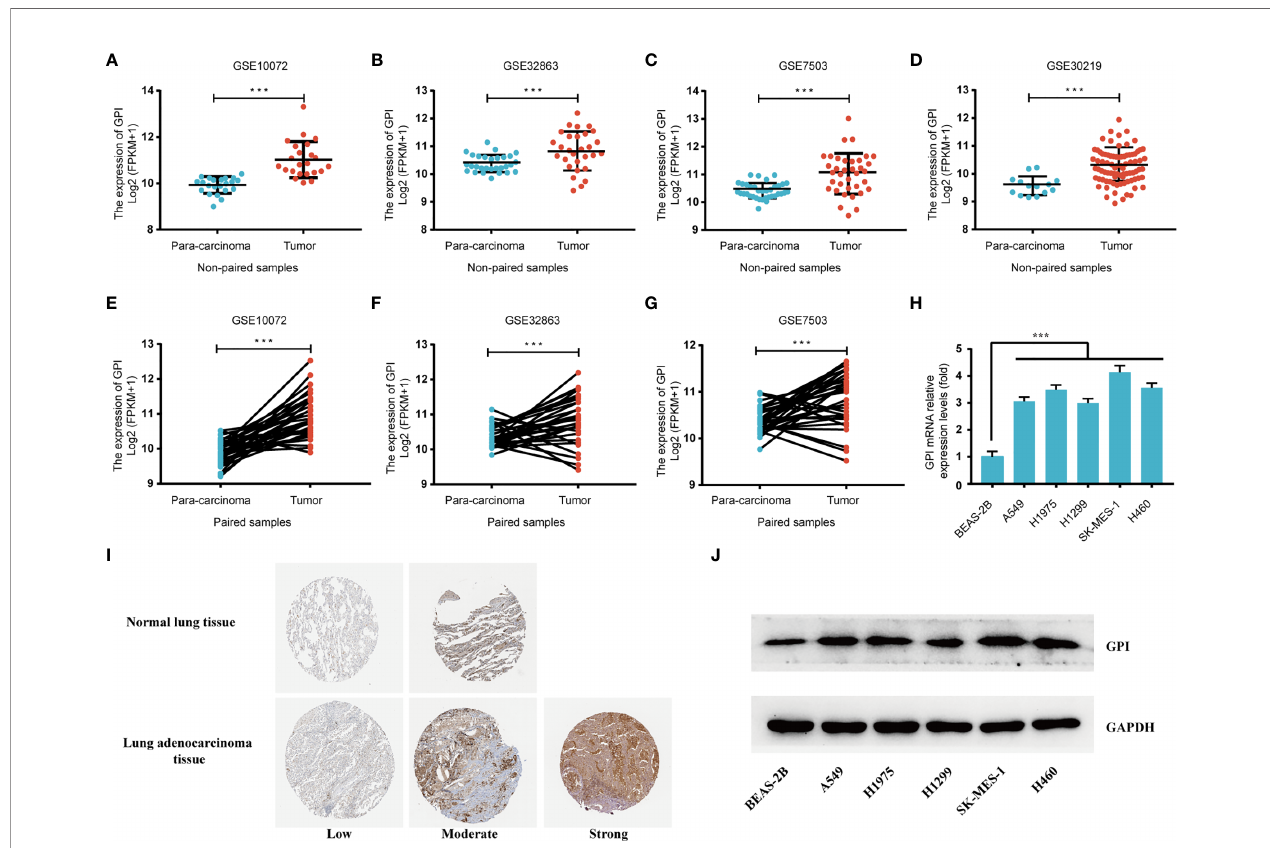
FIGURE 3 | Validation of the high expression of glucose-6-phosphate isomerase (GPI) in lung adenocarcinoma (LUAD) using independent external databases and cell lines. (A – D) Expression of GPI in tumor and unpaired paracarcinoma tissues of the GSE10072, GSE32863, GSE7503, and GSE30219 datasets in the Gene Expression Omnibus (GEO) database. (E – G) Expression level of GPI in tumor and paired adjacent tissues in the GSE10072, GSE32863, and GSE7503 datasets of the GEO database. (H) Transcriptional level of GPI in different non-small-cell lung cancer (NSCLC) cell lines. ( I ) Validation of the expression level of GPI in LUAD using the Human Protein Atlas database (immunohistochemistry). (J) Western blot detecting the protein expression level of GPI in different NSCLC cell lines. ***p <